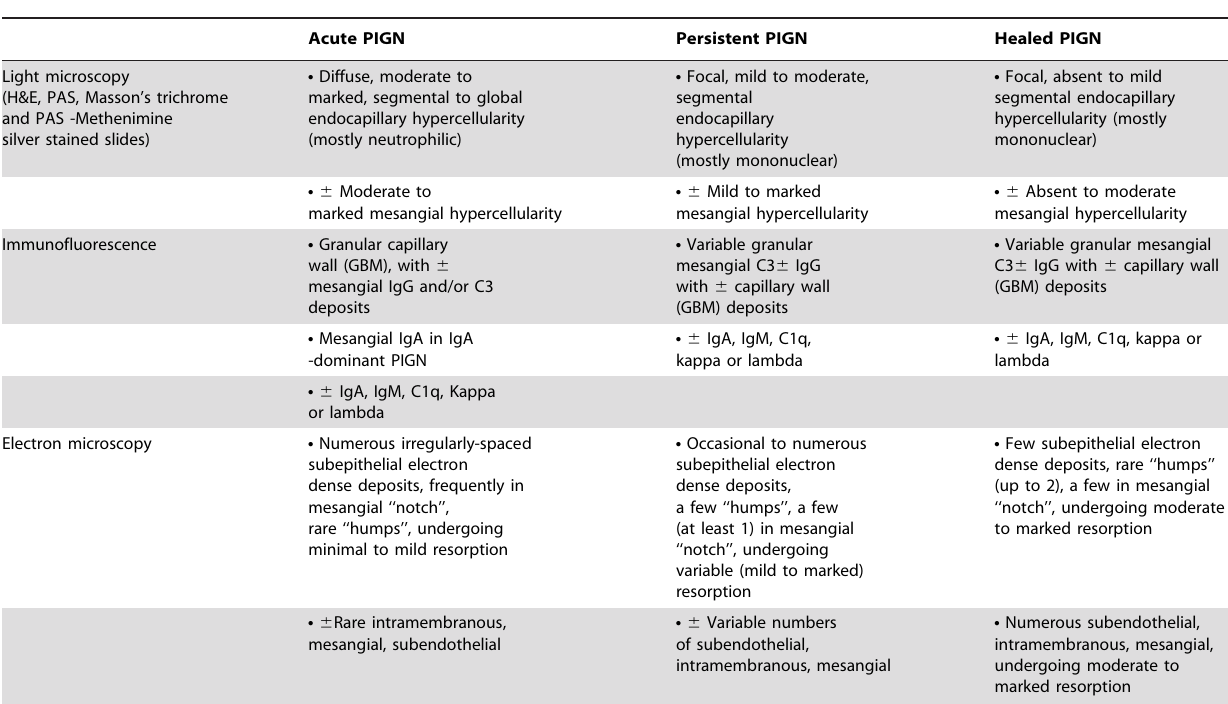
Table 1. Histopathological classification of postinfectious glomerulonephritis.